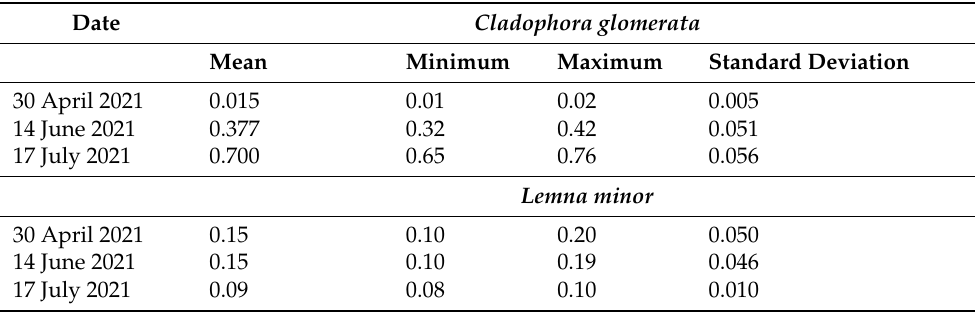
Table 8. The mean value, the minimum value, the maximum value, and the standard deviation of the size of the patches of Cladophora glomerata and Lemna minor (m 3 ).